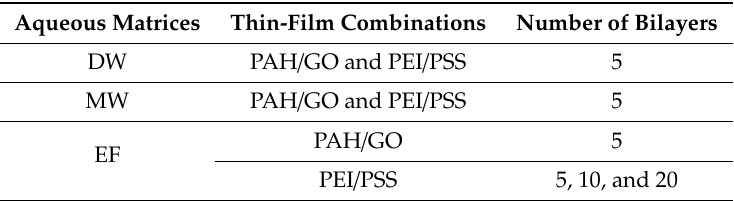
Table 2. Characteristics of the thin-films deposited on BK7 solid support with gold interdigitate electrodes to characterize the aqueous solutions